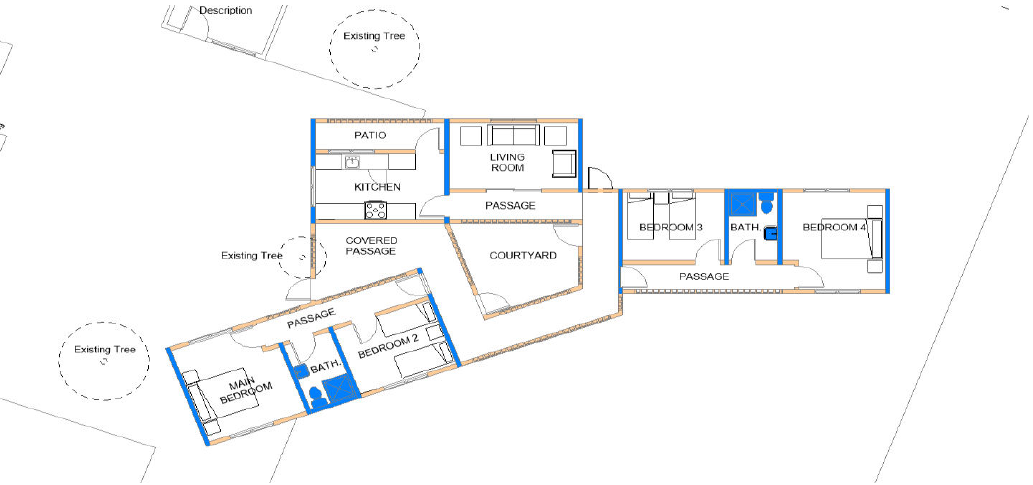
Figure 12: Secondary level (orange) completed. By author,